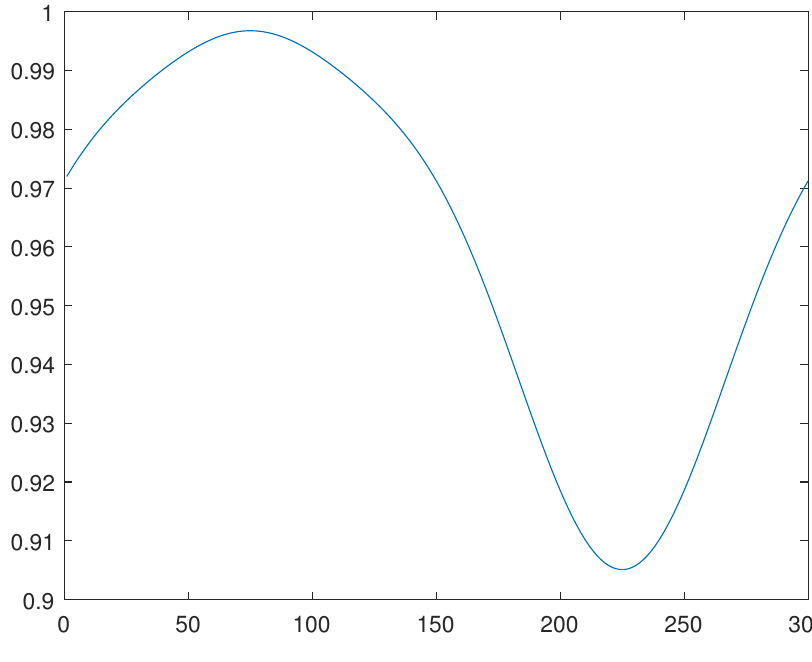
Figure 4. Line 4, solution u 4 ( x ) through the general method of